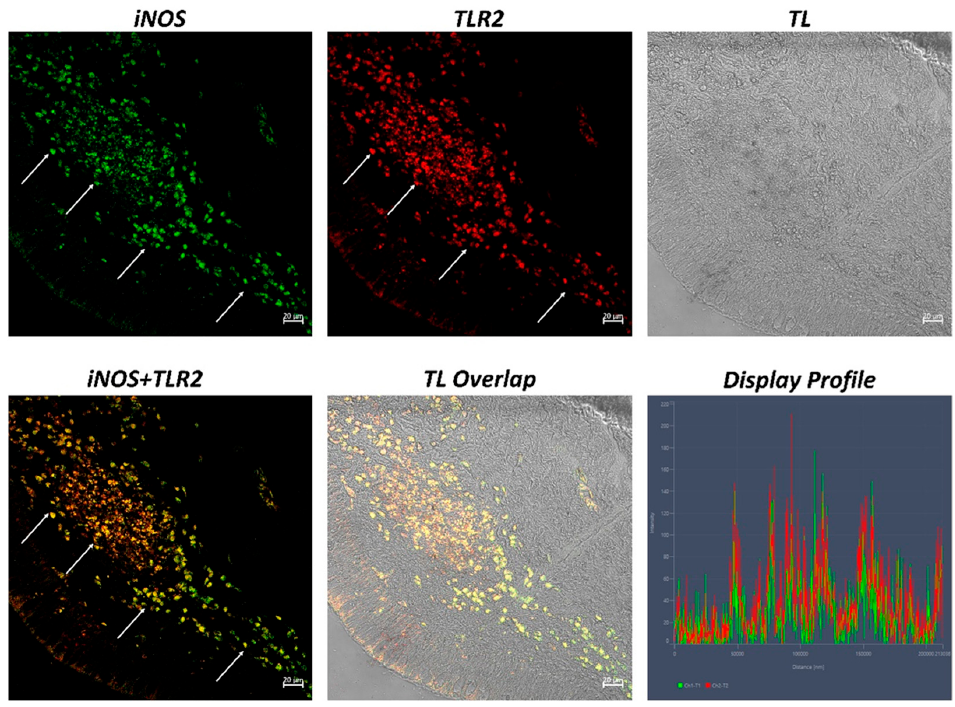
Figure 5. Section of the H. niloticus gut (immunofluorescence 20x, scale bar 50 μ m). Lymphocytes that are positive for CD4 and 5-HT are scattered in the submucosa (arrows). The presence of neuroendocrine cells that are immunoreactive to 5-HT can also be noted (arrowheads). The “Display profile” function highlights the colocalization. TL = transmitted light.